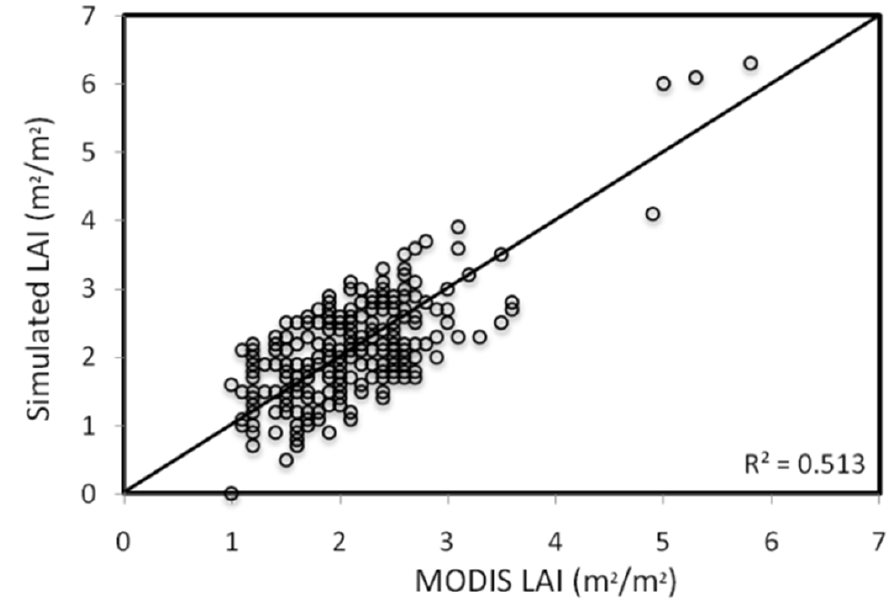
Figure 9. Correlation plot for maximum LAI.